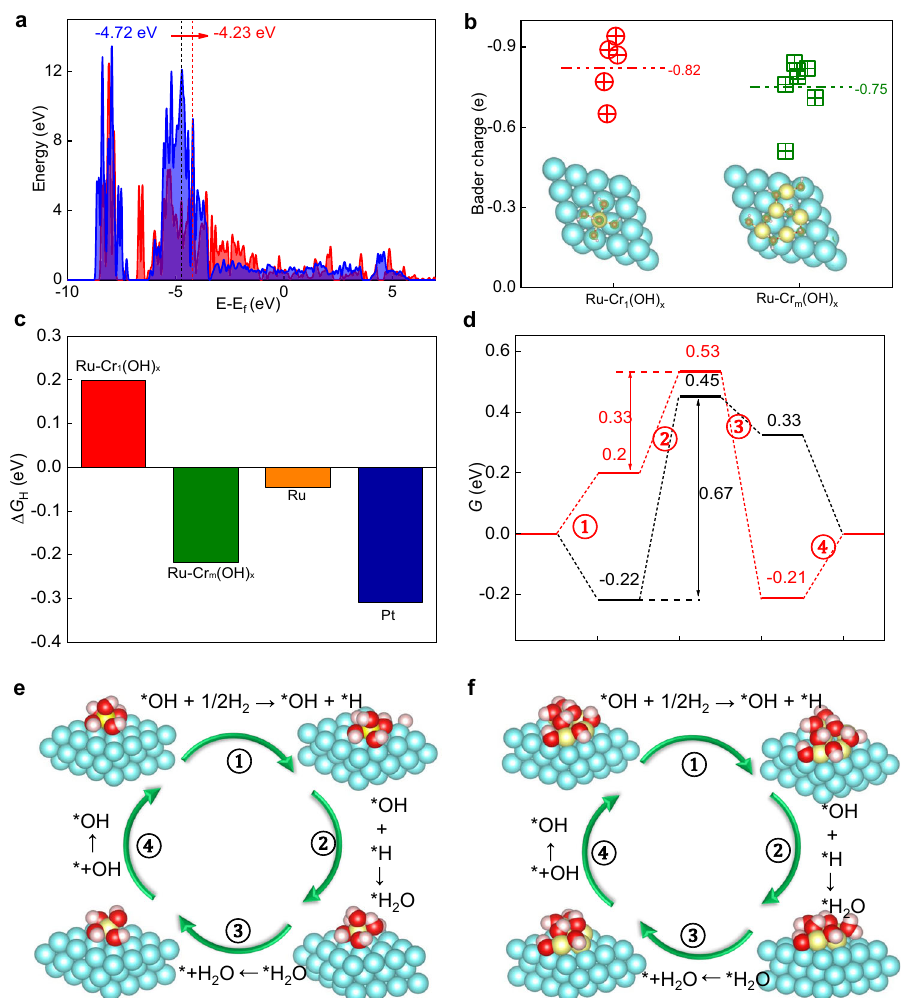
Fig. 7 | DFT calculation results. a DOS of O 2 p for Ru – Cr 1 (OH) x (red) and Ru – Cr m (OH) x (blue).The dashed vertical lines represent the position of O 2 p -band center. b Baderchargeanalysisof OatomsforRu – Cr 1 (OH) x and Ru – Cr m (OH) x .The labeled number is the average Bader charge of O atoms. c Free energy for H